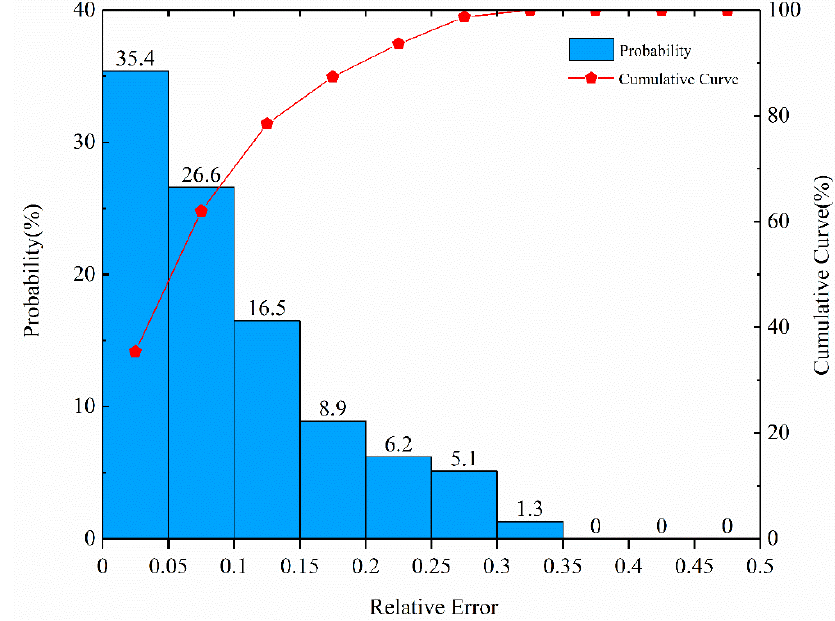
Figure 15. Relative error distribution of CNN prediction model.